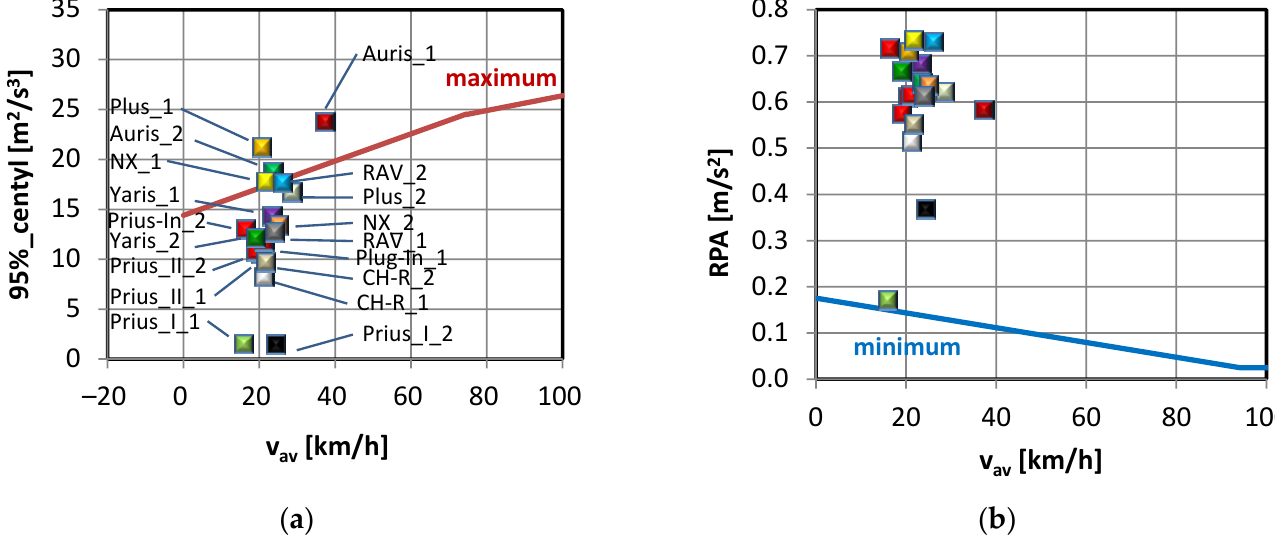
Figure 6. Conditions for carrying out tests against the background of the new requirements of the RDE regulations: ( a ) 95%_centyl; ( b ) average value of positive vehicle acceleration.